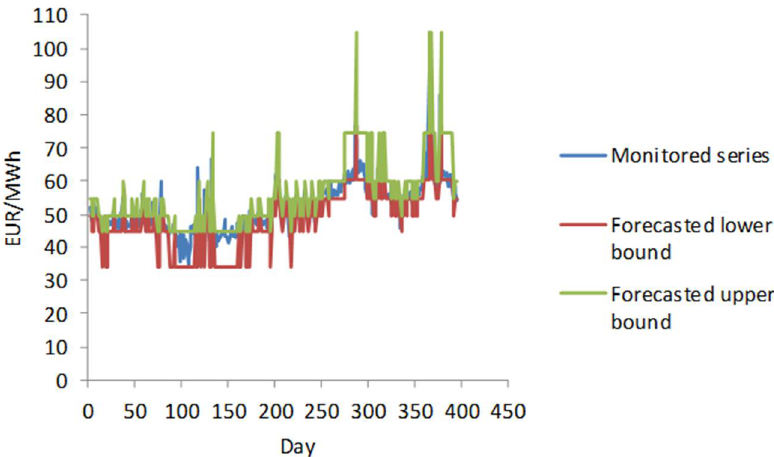
Figure 9. Monitored series and forecasted interval time series.